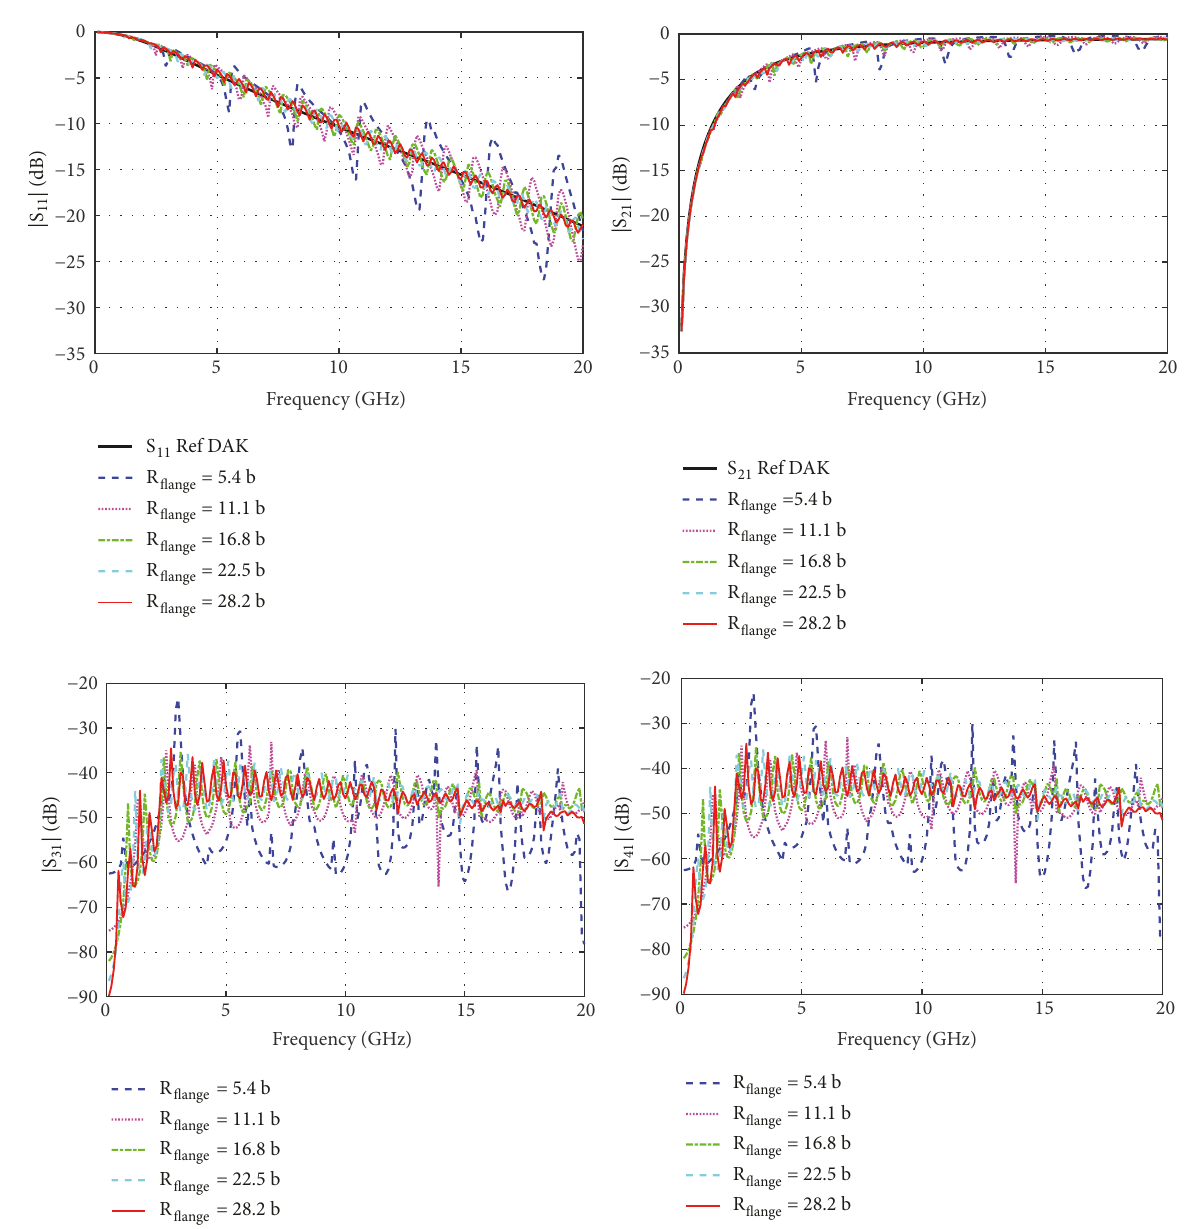
Figure 17: Magnitude (dB) of S 31 and S 41 for model B with TEM and TM 0 flange size (thickness d =0.2 mm, R sample